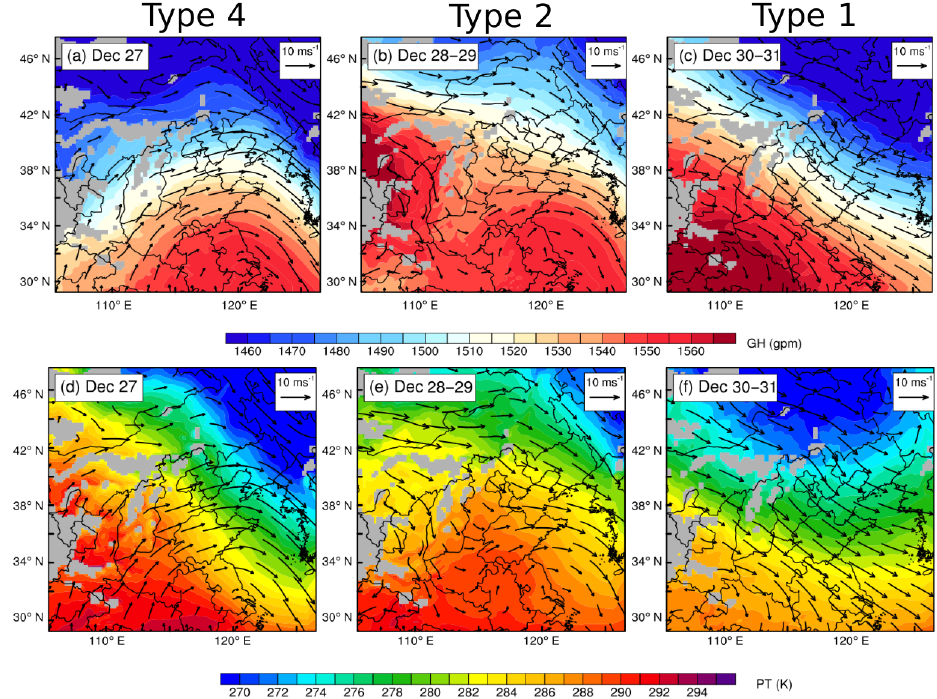
Figure 7. Simulated 850hPa (a–c) GH and (d–f) PT fields on 27, 28–29, and 30–31 December, overlaid with the wind vectors. The regions with terrain higher than the 850hPa level are marked by the grey shading.